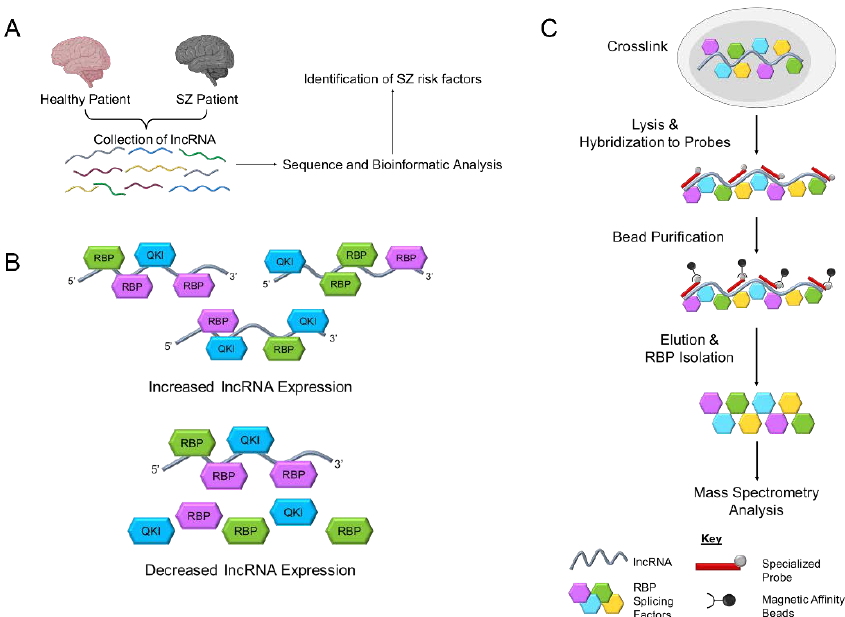
Figure 3. lncRNAs have diverse cellular functions in SZ. ( A ) Comparing transcriptomic alterations of lncRNAs, including GOMAFU , between healthy controls and SZ patients provides insights into how lncRNAs are potential risk factors for SZ. ( B ) lncRNA are capable of interacting with and modulating the function of RNA-binding proteins (RBPs). Increased expression of GOMAFU results in sequestration of RBPs, including the schizophrenic-related RBP quaking (QKI). In contrast, decreased GOMAFU expression releases RBPs to regulate their targets. ( C ) New methods have been developed to characterize the interactions between lncRNAs and RBPs. In general, these new methods involve crosslinking lncRNA with RBPs in vivo, lysing cells, and hybridizing probes to lncRNA of interest. This is followed by purification using magnetic beads, elution of specific complexes, and isolation of RBPs. Novel RBPs in the lncRNA − RBP interactome are then identified by mass spectrometry and further confirmed by immunoblotting. Colored hexagons are representative